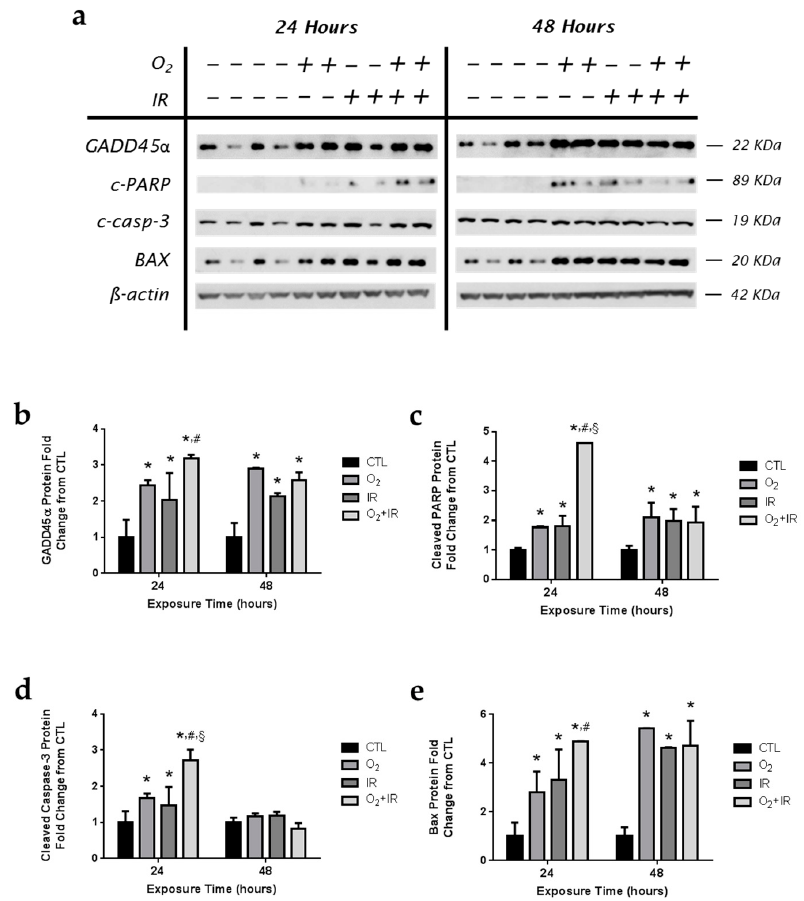
Figure 8. Determination of apoptosis and genotoxic stress in lung epithelial cells exposed to hyperoxia, radiation, and double-hit combination challenge. Non-tumorigenic murine alveolar type II epithelial cells (C10) were evaluated after 1 and 2 cycles of hyperoxia and radiation exposure and evaluated analysis of band intensity for ( b ) GADD45 α ; ( c ) cleaved-PARP; ( d ) cleaved caspase-3; and ( e )